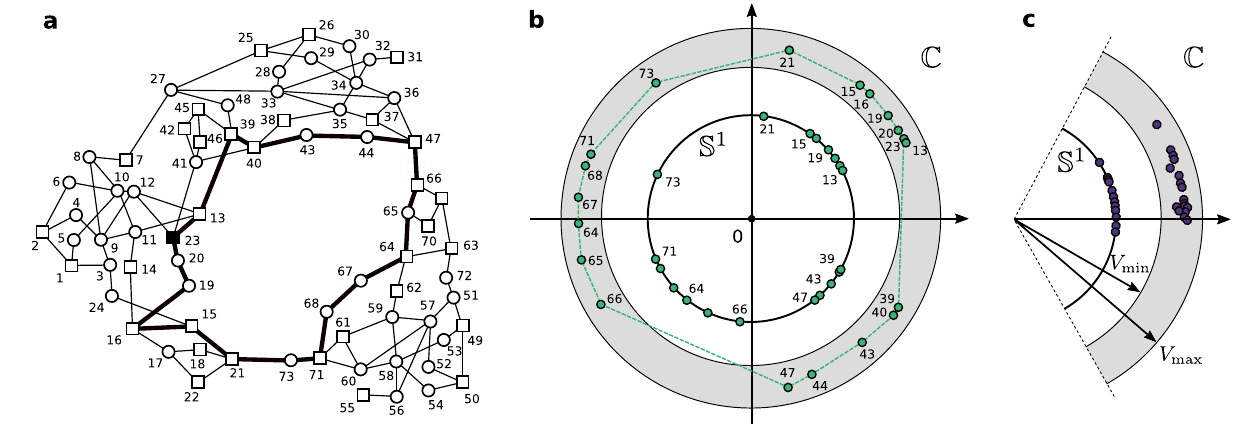
Fig. 4 | Multistability in the full power fl ow equations for the IEEE RTS-96 test case. Comparison of the power fl ow solutions and Kuramoto – Sakaguchi syn- chronousstates on the IEEE RTS-96 test case 42 . a Geographicrepresentation of the system. Circles are loads and squares are generators. The network is composed of n =73 nodes, m =108 edges, and therefore c =36 independent cycles. The long cycle with thick edges is of particular interest, because its length promotes the existenceof loop fl ows while keeping angulardifferences small[see refs.43,44for an extended discussion]. b , c Combined representations of: (outer annulus) the complex voltages for solutions to the full power fl ow equations for an adapted versionofthe IEEERTS-96testcase;(innercircle)the phase anglesof synchronous